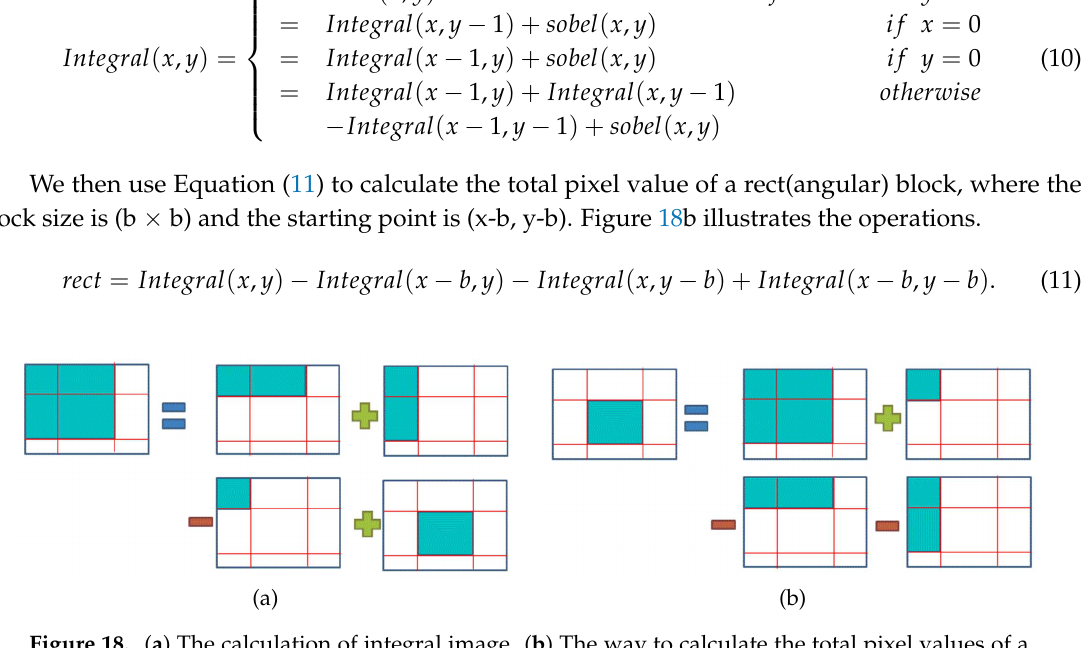
Figure 18. ( a ) The calculation of integral image. ( b ) The way to calculate the total pixel values of a rectangular